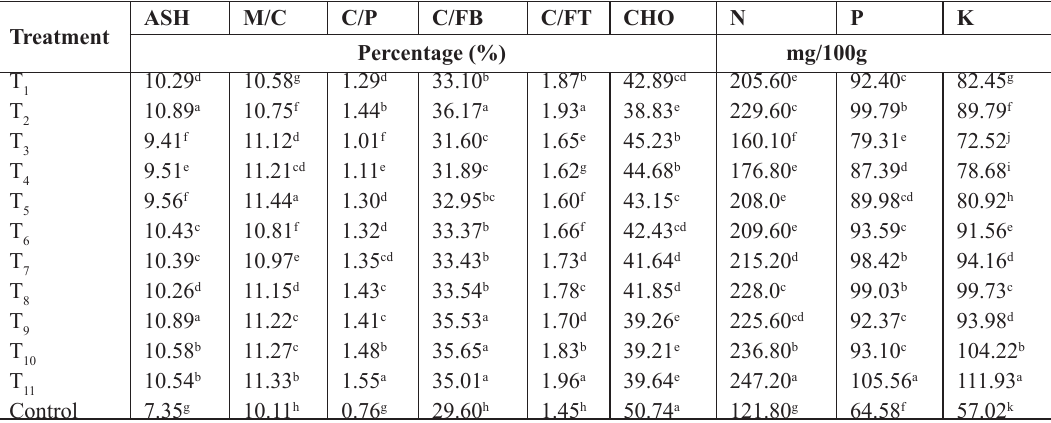
Values with the same superscripts are significantly the same at p<0.05, N=3; DAP=Days After Planting T